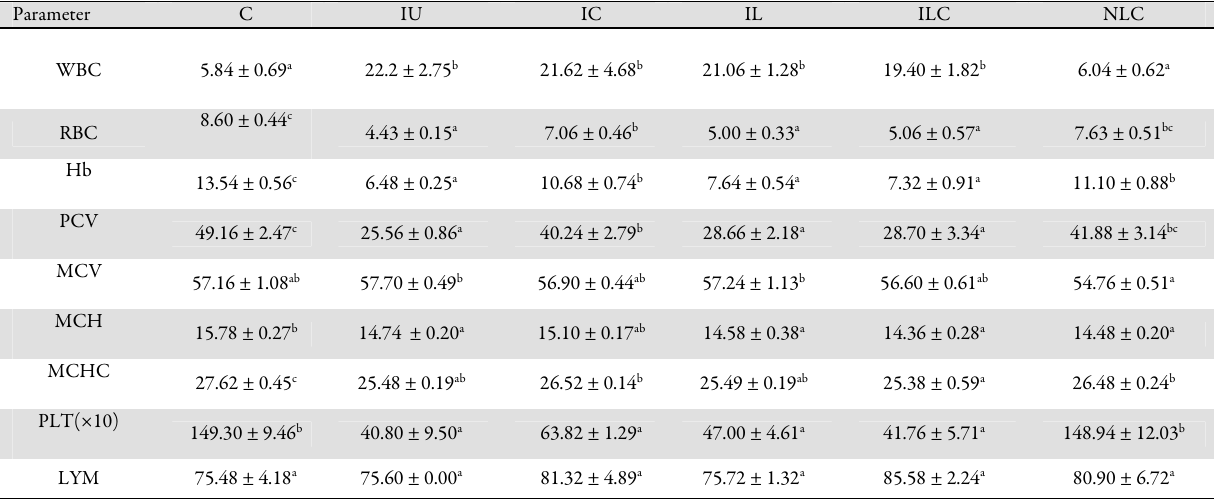
Table 8. Effect of lumefantrine and lumefantrine - copper complex on the concentration of some haematological parameters in the plasma of P. berghei NK-65 infected mice Parameter